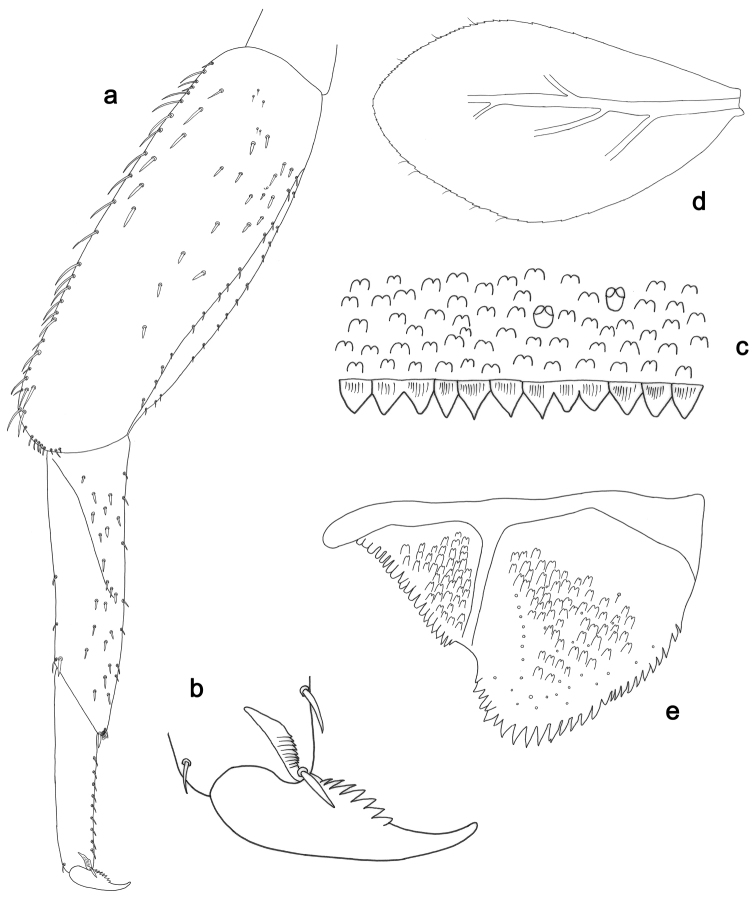
Labiobaetisdendrisetis sp. n., larva morphology: aForelegb Fore claw cTergum IV d Gill IV eParaproct.